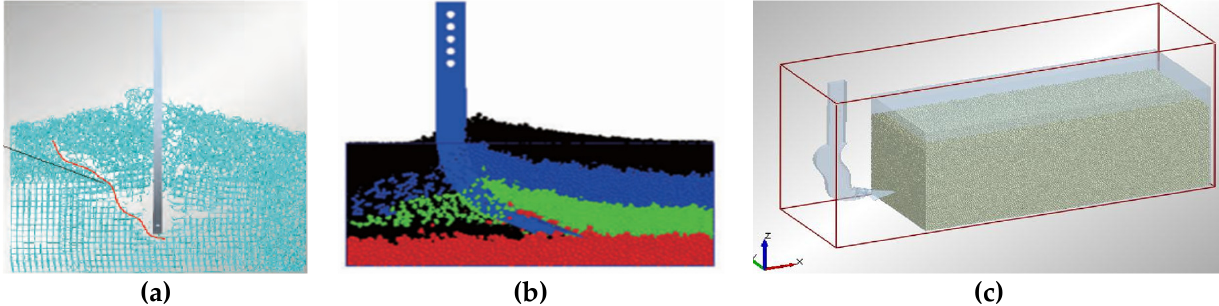
Figure 6. Simulation of a typical subsoiling process [32]. ( a ) Simulation of bonding breakage. ( b ) Soil disturbance in vertical direction [138]. ( c ) Simulation of soil particle velocity [144].